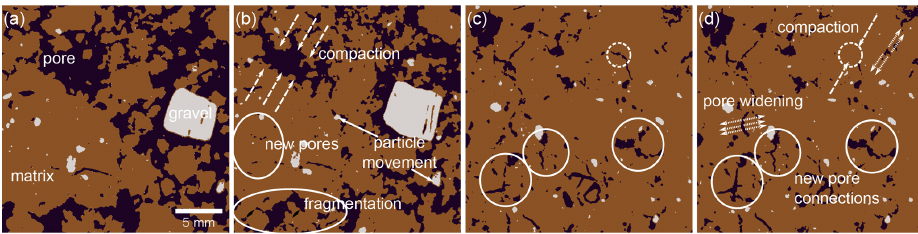
Figure 5. Scheme of soil structure transformation of a repacked sample after 0 (a) and 19 FTCs (b) and of an undisturbed sample after 0 (c) and 19 FTCs (d)